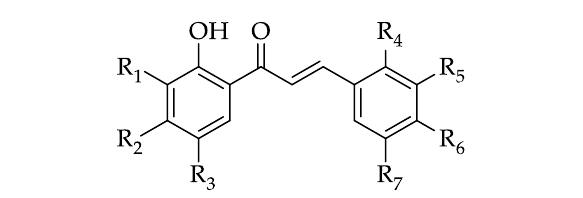
Table 1. Substituents of all the synthesized chalcone and aurone derivatives.